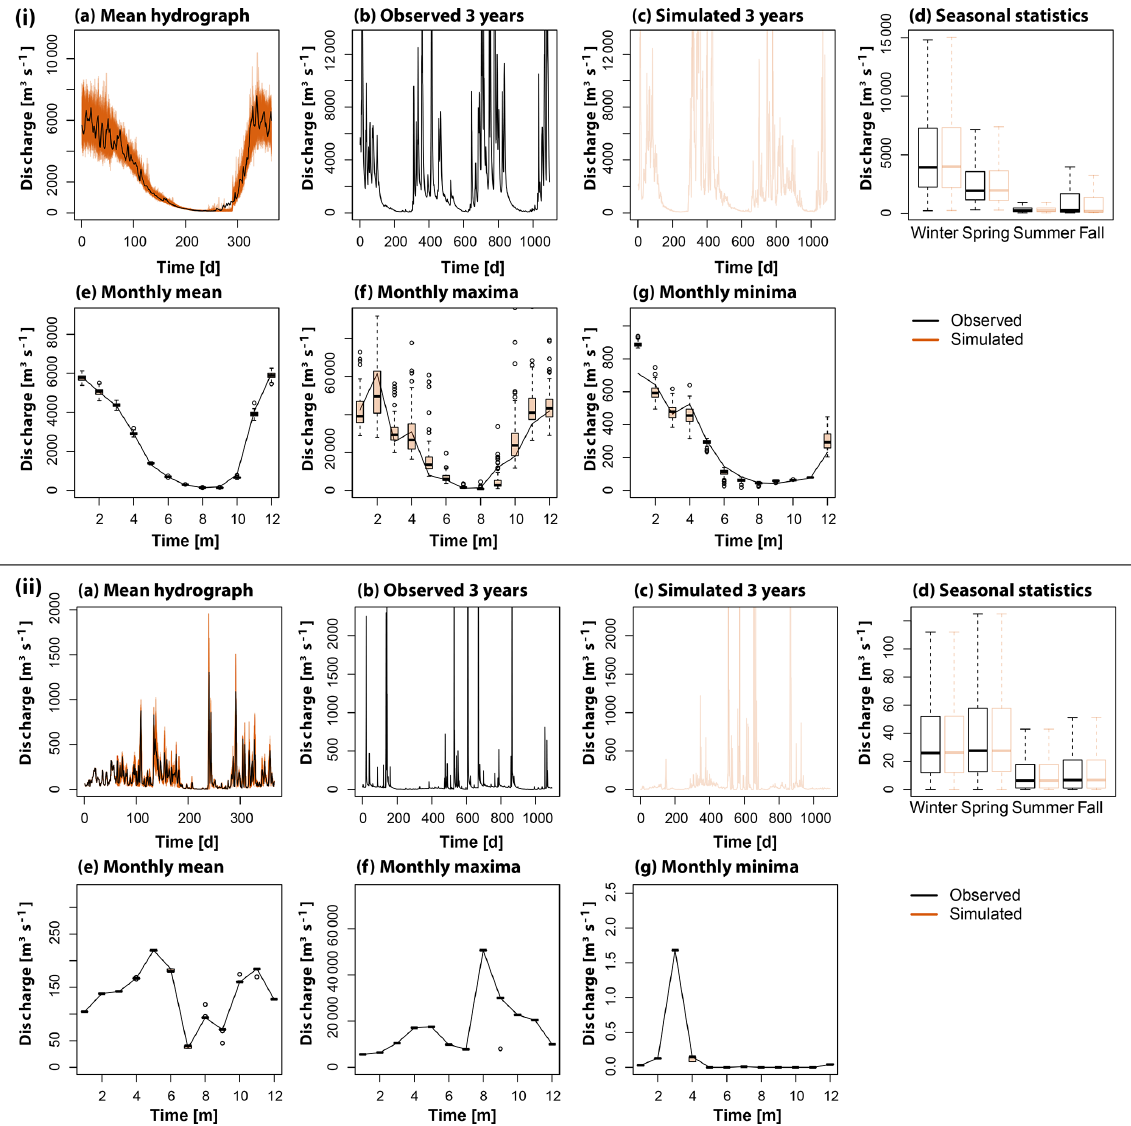
Figure 3. Comparison of observed (black) and simulated (orange) distributional discharge characteristics for (i) the station Nehalem River near Foss, OR (USGS 14301000, id 661) in the Pacific Northwest and (ii) the station Navidad River near Hallettsville, TX (USGS 08164300, id 464): (a) mean annual hydrographs, (b, c) observed and simulated time series for 3 years, (d) seasonal discharge distribution characteristics, (e) monthly mean discharge, (f) monthly maximum discharge, and (g) monthly minimum